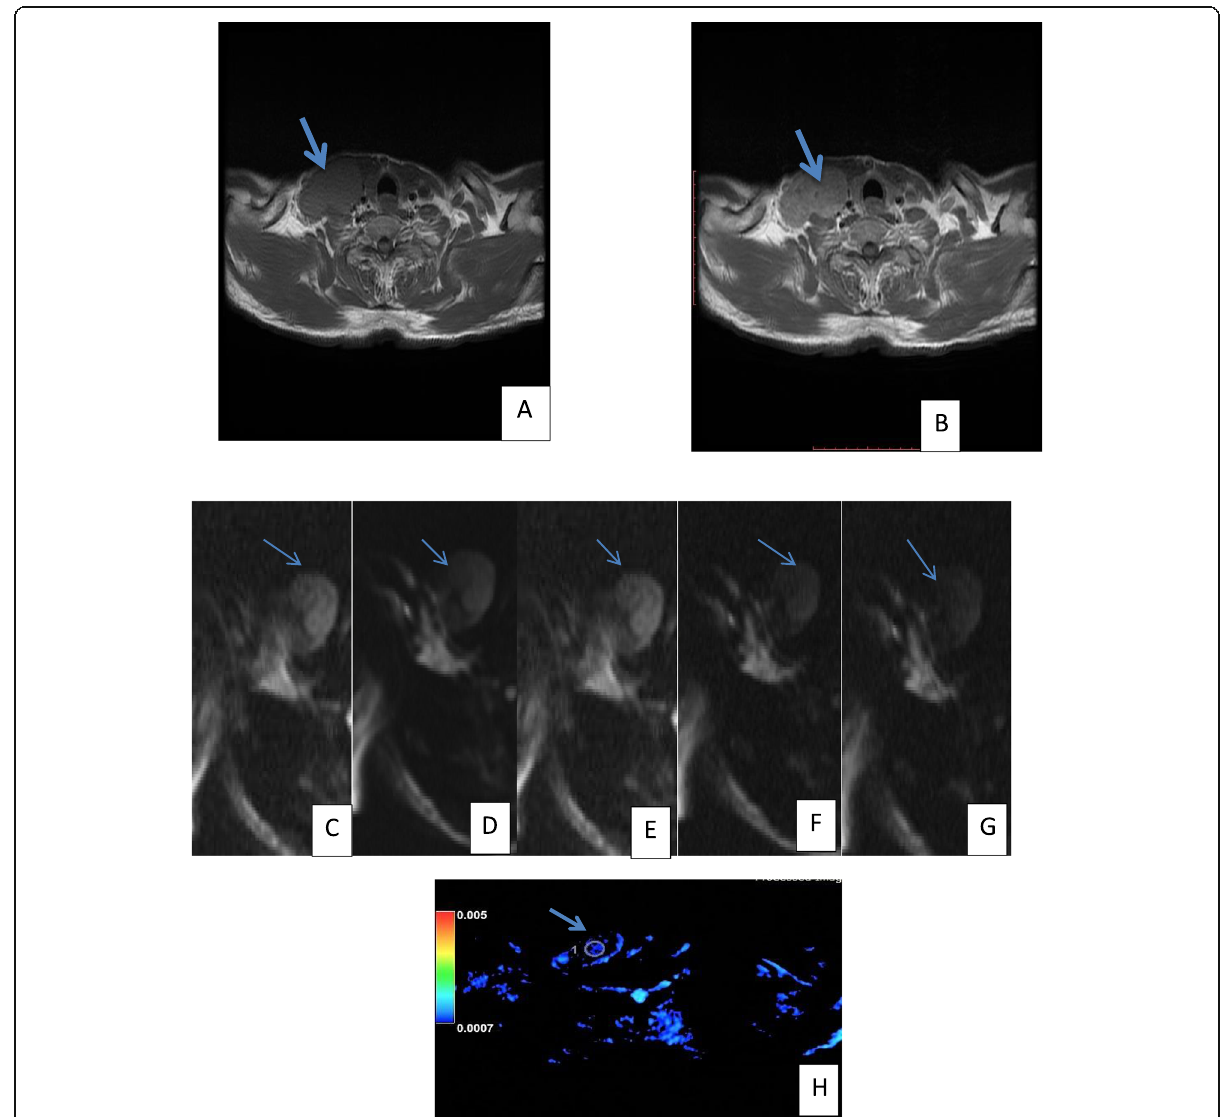
Fig. 1 Sixty-four-year-old male with metastatic anaplastic carcinoma to right supraclavicular lymph node. a Axial T1. b Axial T1 + C. c – g Axial diffusion-weighted imaging with b values: 0, 50, 400, 800, and 1000 respectively. h ADC map showed a well-defined right supraclavicular neck mass appeared isointense signal in T1 and definite homogenous enhancement after IV contrast; the mass showed central satellite appearance and outer lobulations and elicited high signal in DWI, in both low and high b values (restricted diffusion), ADC value = 0.69 × 10 − 3 s/mm 2